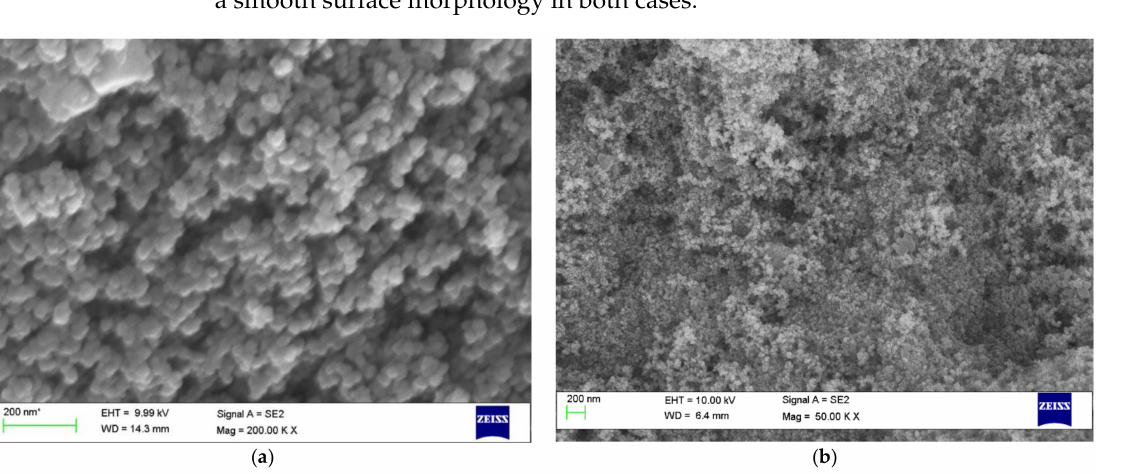
Figure 7. SEM images of the nanoconjugates formed from ( a ) aqueous extract and ( b ) methanolic extract.